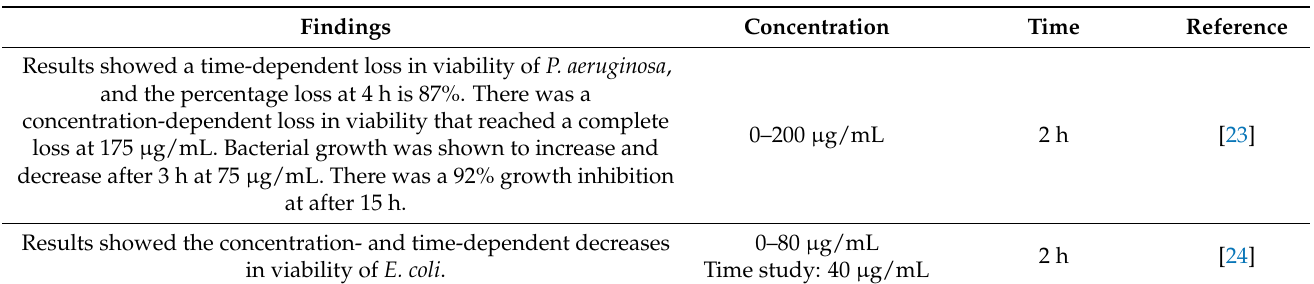
Table 1. Cont. Findings Concentration Time Reference